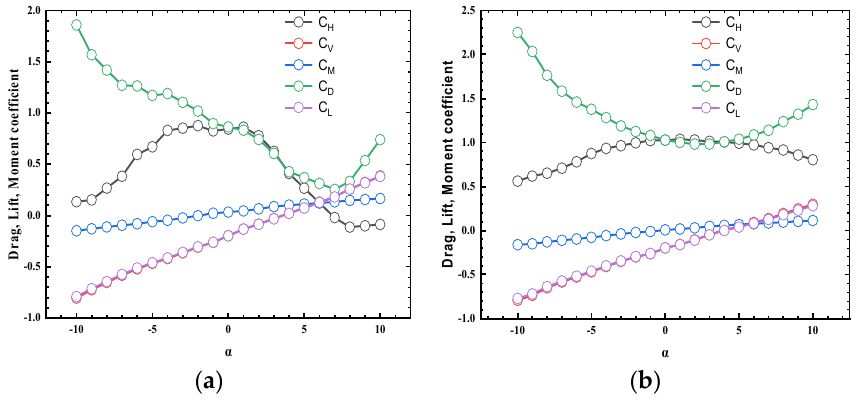
Figure 8. Aerodynamic coefficients as function of the wind attack angle α . ( a ) Construction; ( b )